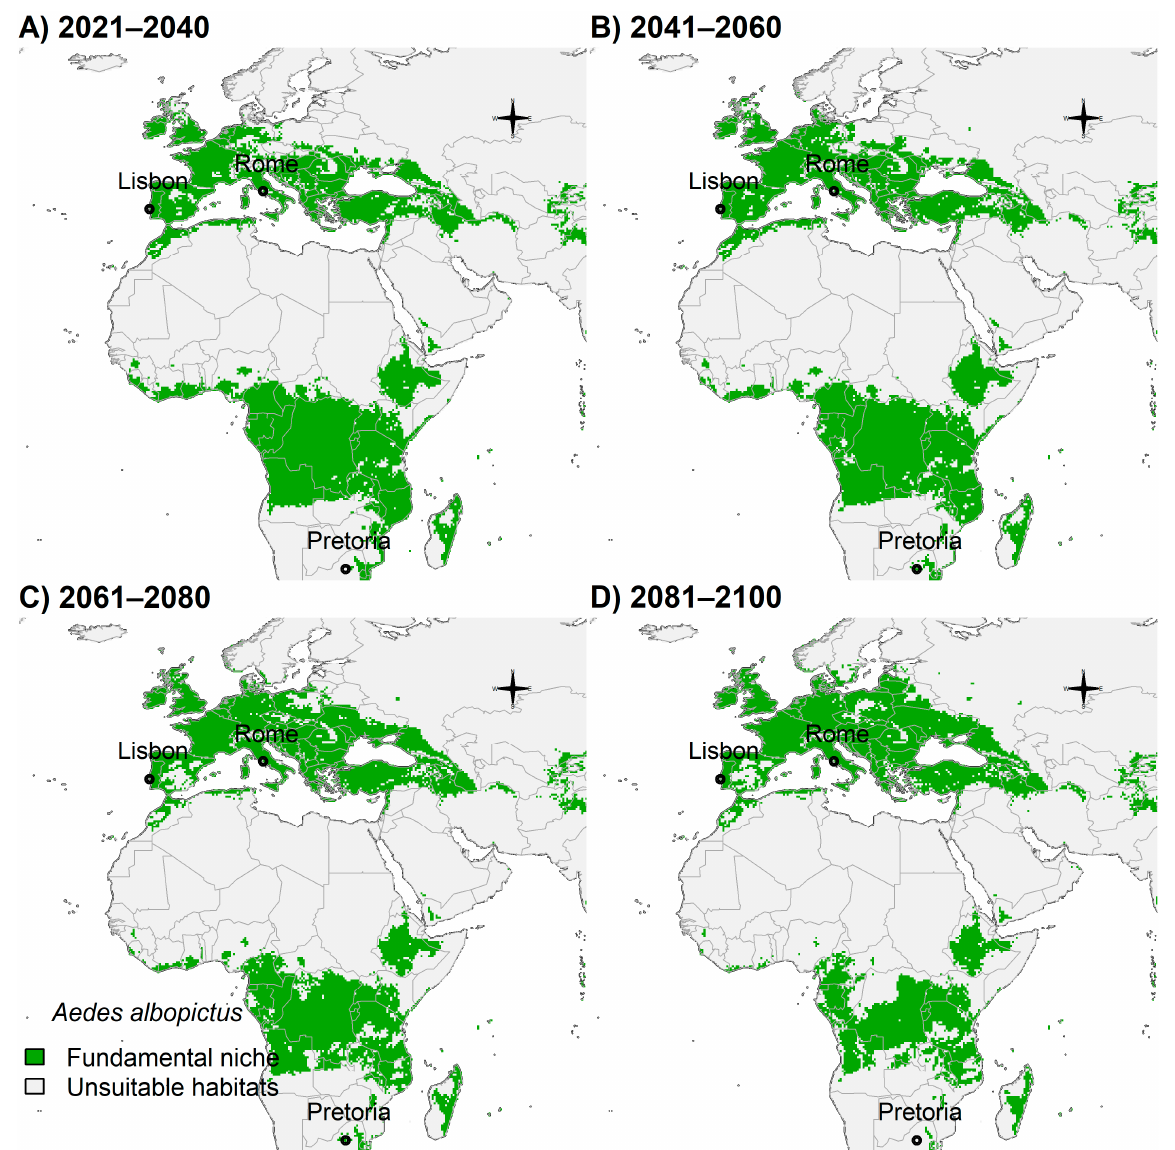
Figure 7. Potential future distribution of Ae . albopictus in Europe and Africa: ( A ) 2021–2040; ( B ) 2041–2060; ( C ) 2061–2080; and ( D ) 2081–2100. Future climate projections based on the global climate model GFDL-ESM4.1 by NOAA in the shared socio-economic pathway SSP3-7.0 of region rivalry. Locations of capitals of countries were shown for reference.